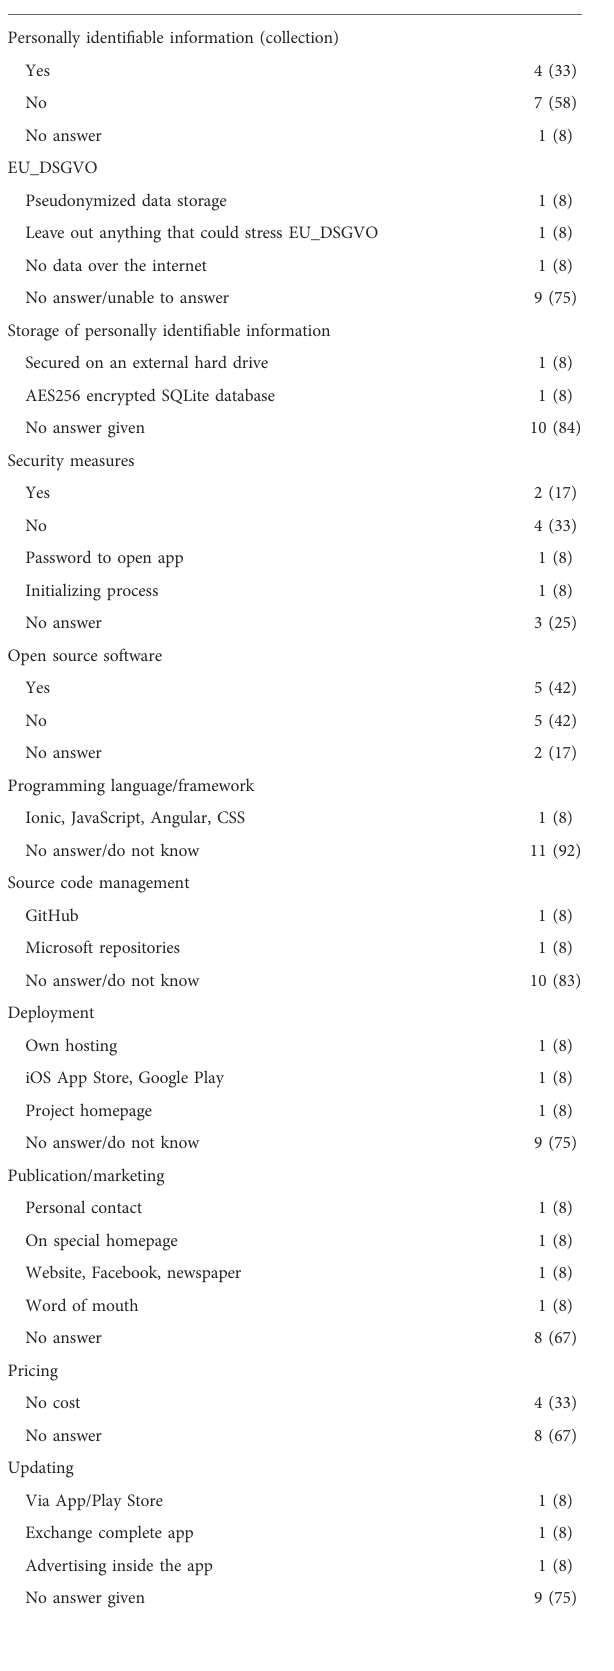
TABLE 5 App security, technology, and dissemination ( N